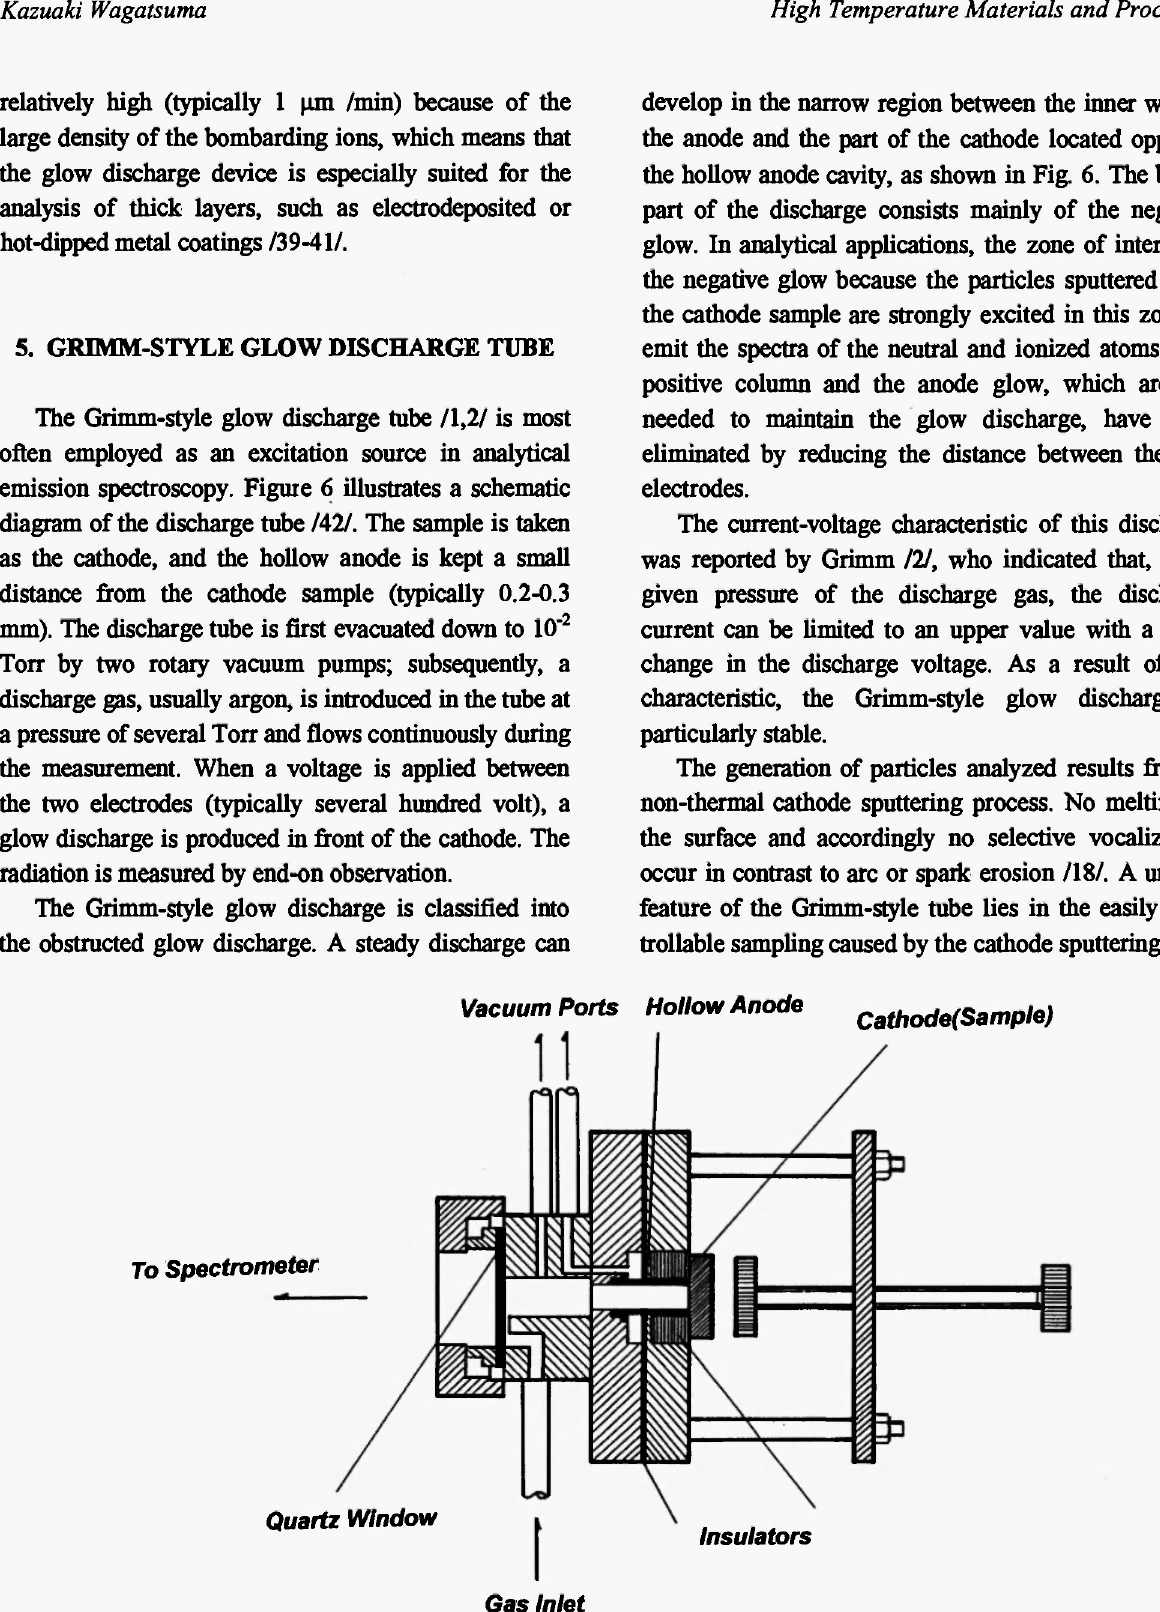
Fig. 6: Cross-section diagram of Grimm-style glow discharge tube